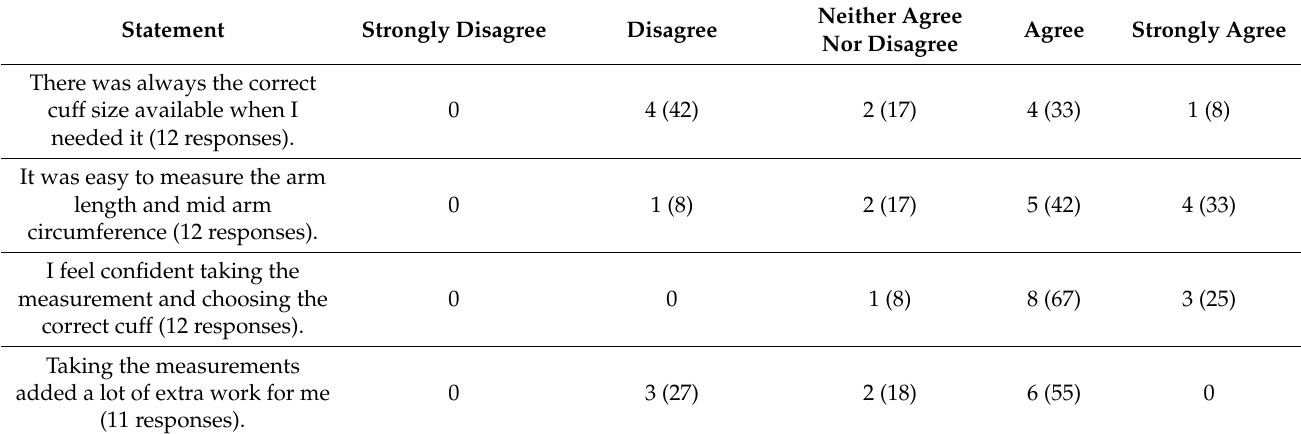
Table 4. Statements and Likert scale responses from 18 pre-operative nurses following implementation of the intervention. Expressed as number (percent).